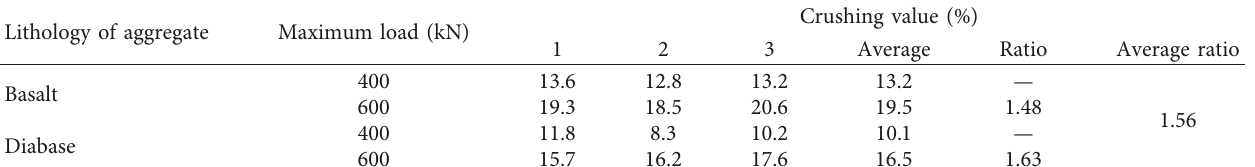
Table 7: Measured crushing values of coarse aggregates under different maximum